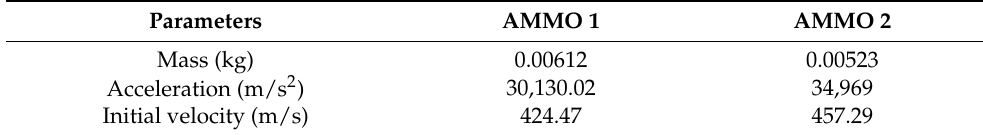
Figure 3. The meshing part result with 0.5 mm element size ( a ) part assembly; ( b ) AMMO 1; ( c ) AMMO 2. Table 4. Projectile initial